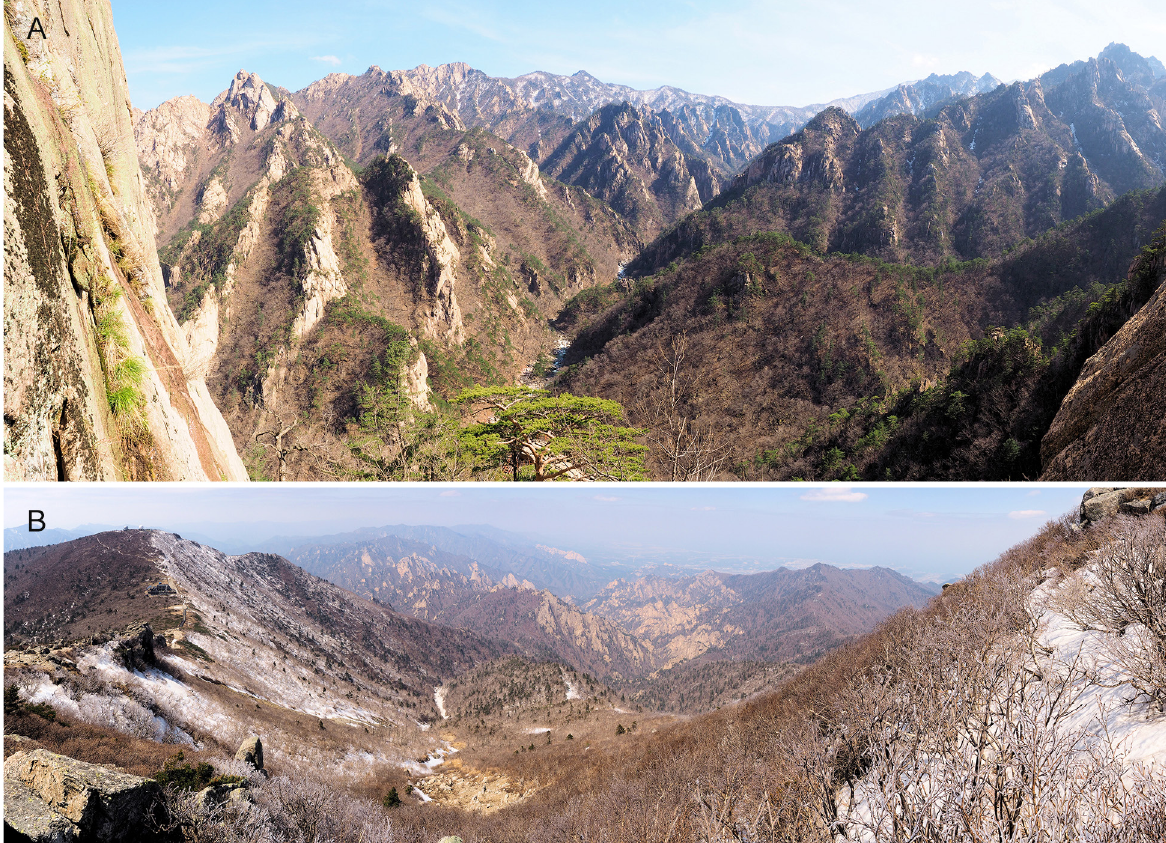
Fig. 5. Representative geomorphic landscapes on different lithologies in Seoraksan (Photos M. Kasprzak). A – abundant rock slopes, sharp-crested ridges and ravines in Cretaceous granites, B – smooth slope topography in Proterozoic granites and